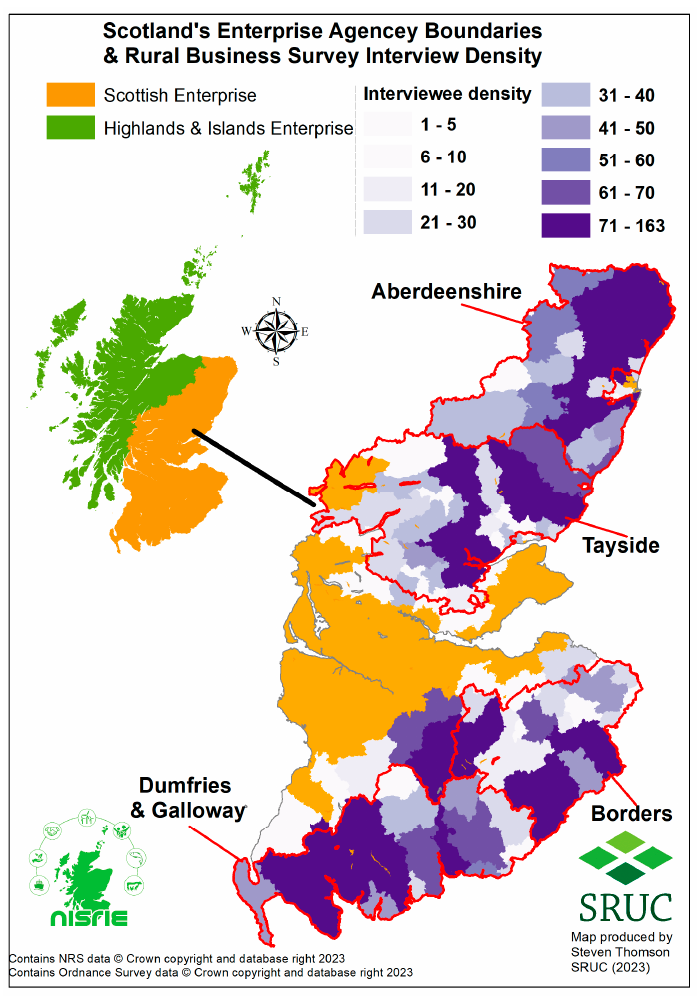
Figure 2. Map of the four Scottish regions included in this study. Source: map produced by Steven Thomson.